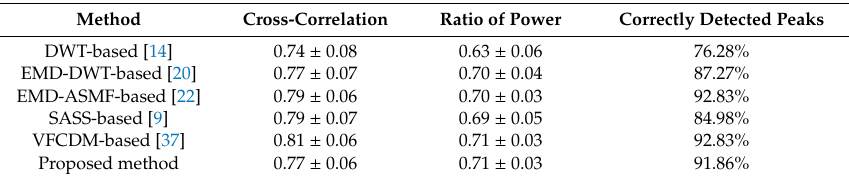
Table 6. Denoising performance comparison on the armband sequences with motion noise artifacts: cross-correlation between denoised and clean sequences represented as mean ± sd, ratio of power for denoised sequences represented as mean ± sd, and percent of correctly detected peaks in denoised sequences.